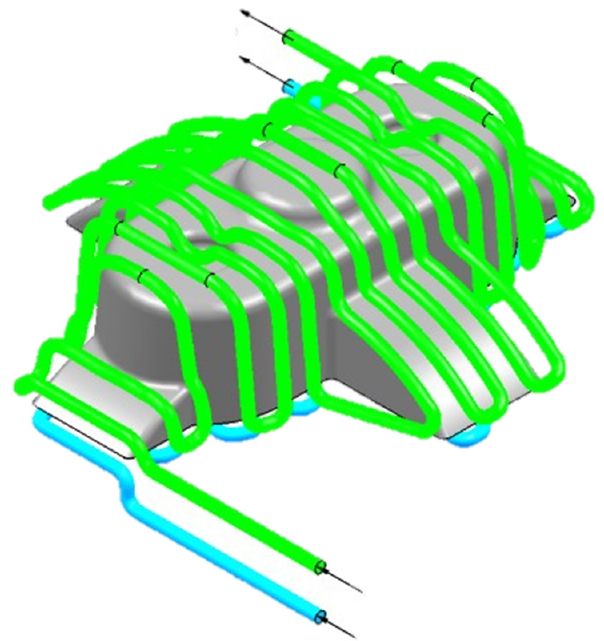
Figure 9. Three-dimensional computer-aided design modeling of conformal type cooling channels, adapted from Torres-Alba et al. adapted from Torres-Alba et al. [16] .